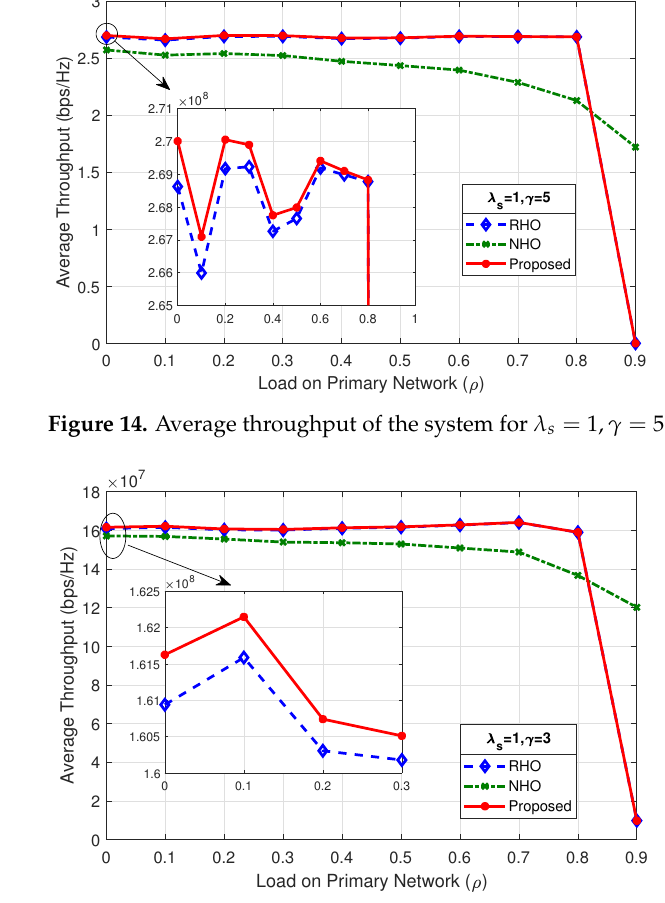
Figure 15. Average throughput of the system for λ s = 1, γ =